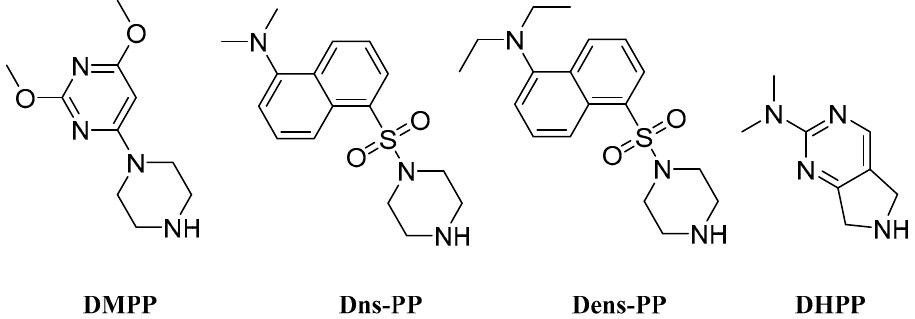
Figure 5. Secondary amines as derivatization reagents for LC-HRMS analysis of FFAs.